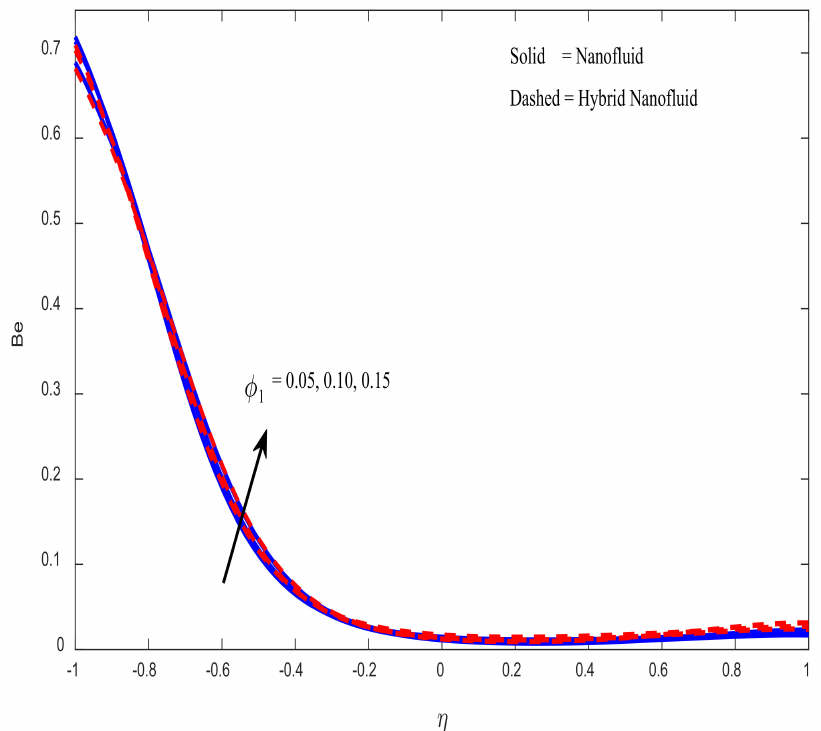
Figure 22. Influence of φ 1 on the Bejan number